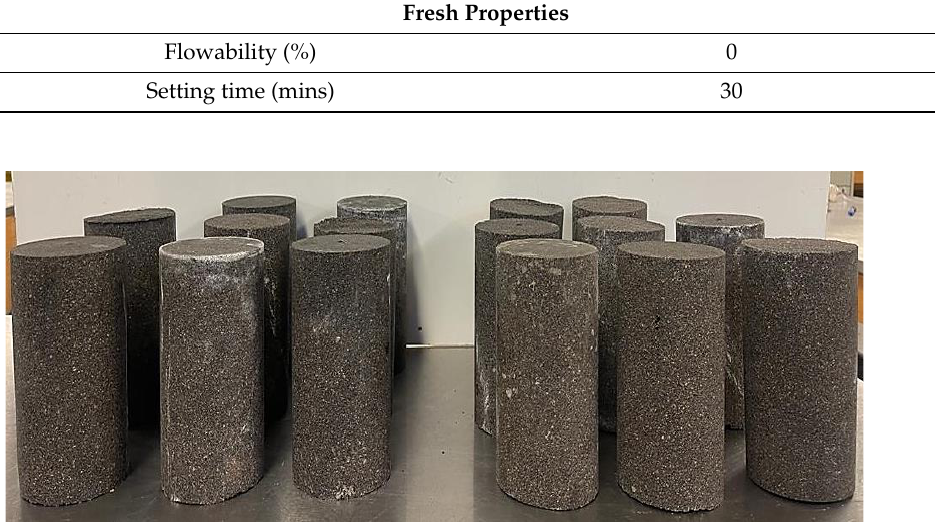
Figure 4. BPC concrete specimens produced showing no foaming in specimens.